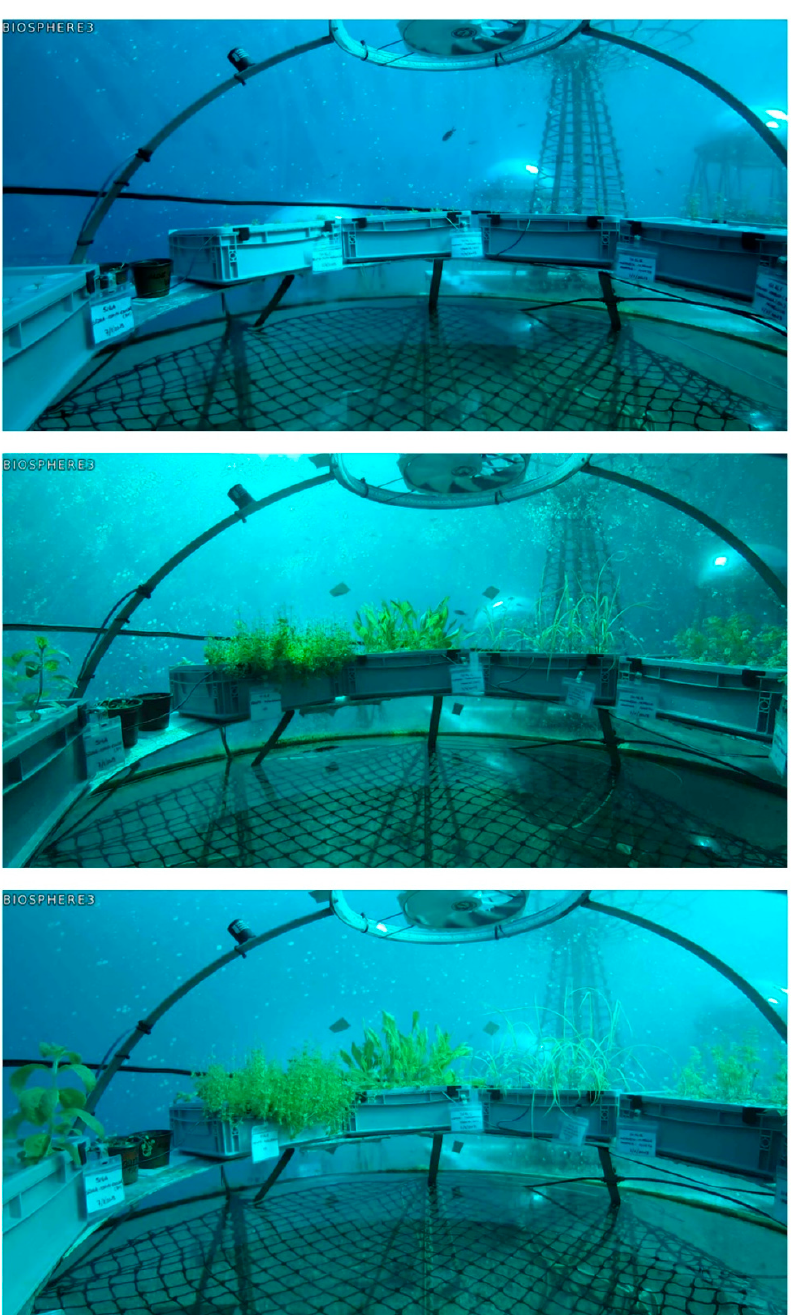
Figure 3. Photographic illustrations of a biosphere interior. From top to bottom: 12th day, 31st day, and 47th day after plant sowing.